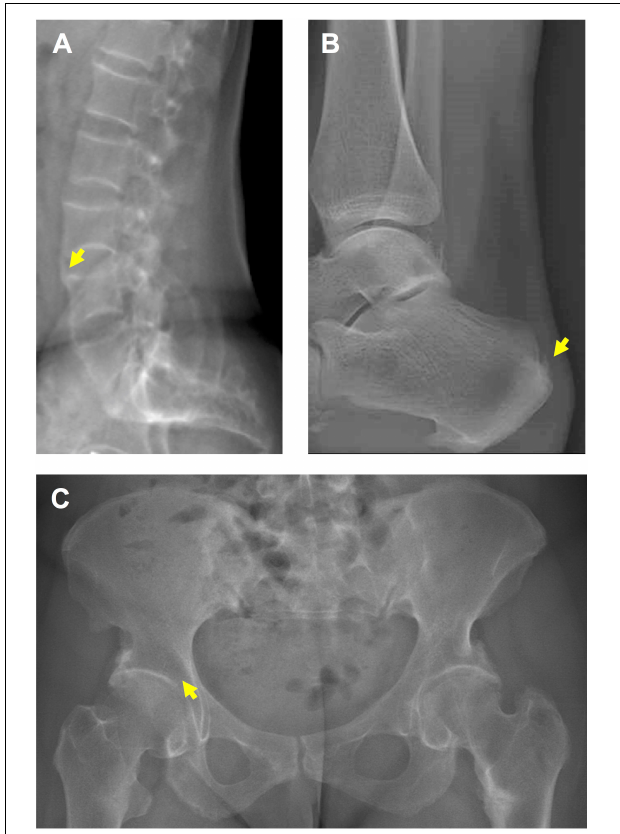
FIGURE 1 | Enthesopathies and osteoarthritis in a 36 year-old female patient with XLH. (A) Spinal enthesophytes (yellow arrow). (B) Enthesophyte (yellow arrow) on the Achille’s tendon. (C) Early osteoarthritis (yellow